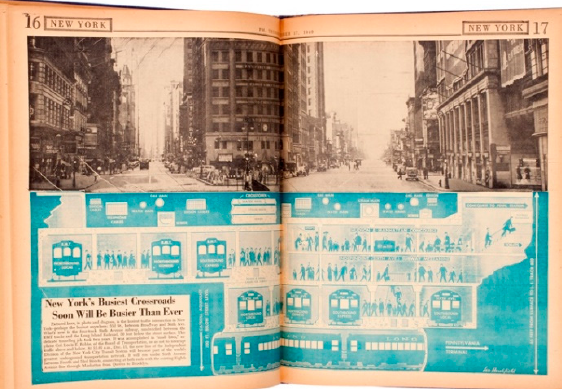
Figure 5. Leo Hershfield, “New York’s Busiest Crossroads Soon Will Be Busier Than Ever”, PM , 17 October 1940. Image courtesy of the International Center of Photography.